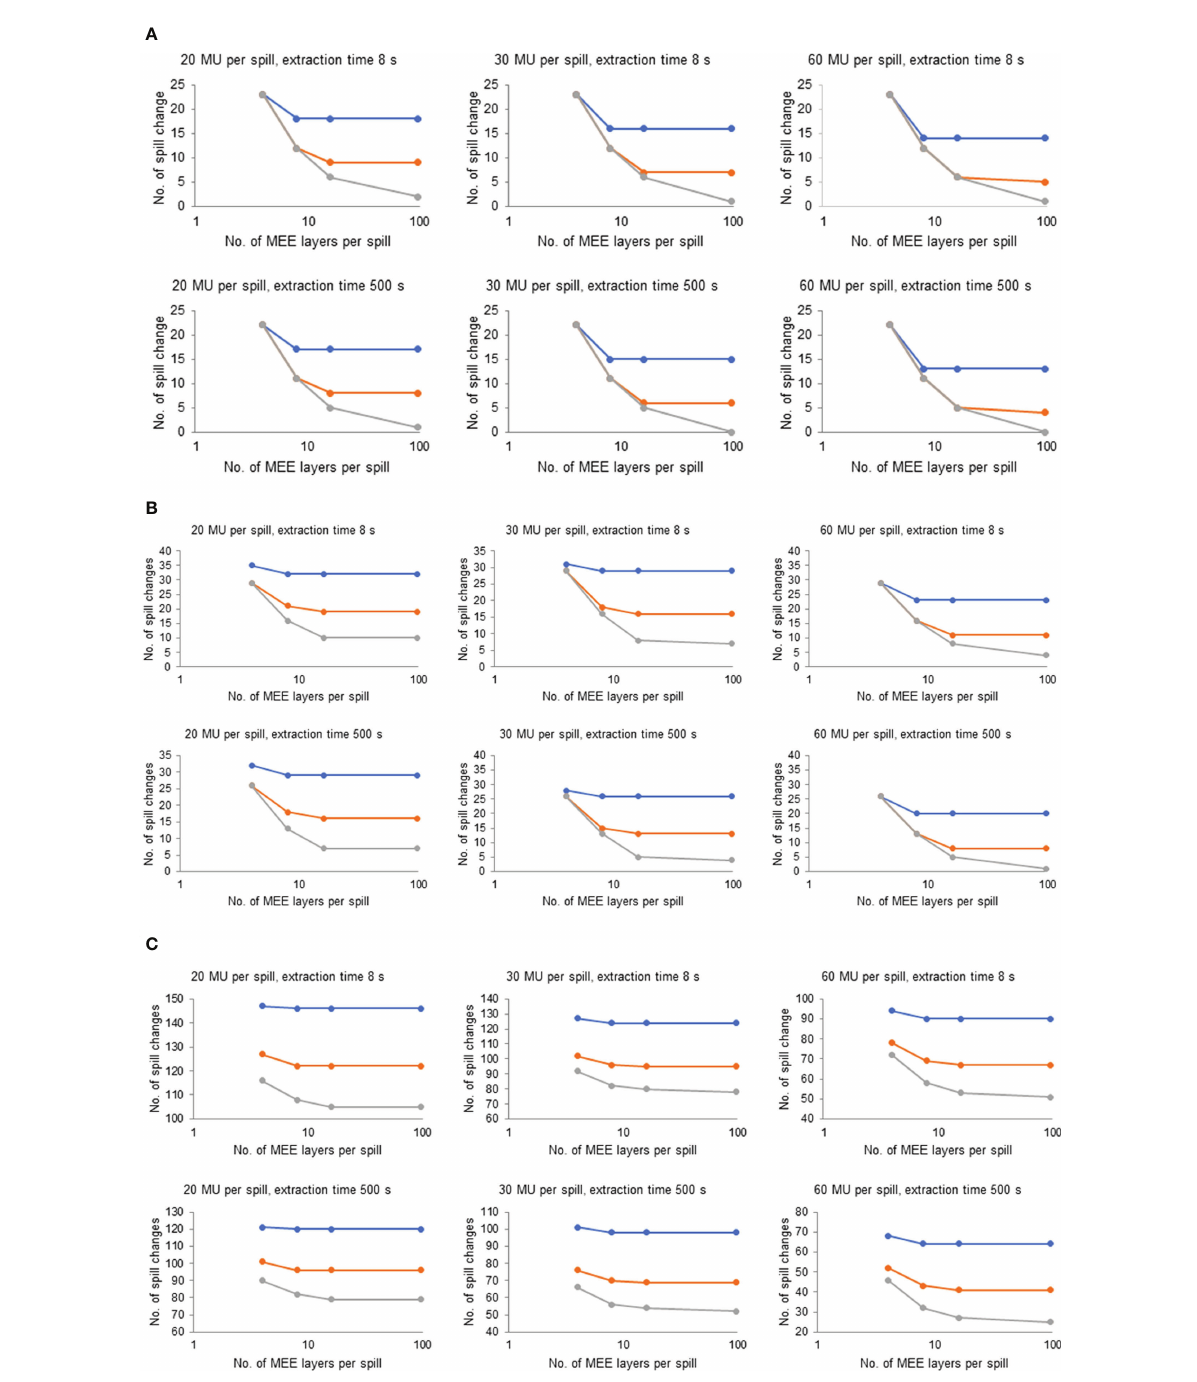
FIGURE 4 Effect of Number of Multiple Energy Extraction (MEE) Layers per Spill on the Number of Spill Changes With Various Recapture Ef fi ciency, Monitor Unit (MU) per Spill, and Extraction Times for 3 Representative Treatment Plans. (A) Representative treatment plan for patient 1 in the head and neck cohort (1.2 GyRBE/fx; 3,957 spots; 0.4 mean MUs per layer; and total plan MU of 40.5). (B) Representative treatment plan for patient 6 in the lung cohort (12 GyRBE/fx; 15,948 spots; 1.6 mean MUs per layer; and total plan MU of 177.8). (C) Representative treatment plan for patient 5 in the breast cohort (2.67 GyRBE/fx; 56,127 spots; 9.0 mean MUs per layer; and total plan MU of 1,613.8). Blue line indicates 50% recapture ef fi ciency; orange line, 80% recapture ef fi ciency; and gray line, 100% recapture ef fi ciency. All treatment plan characteristics are listed in Table